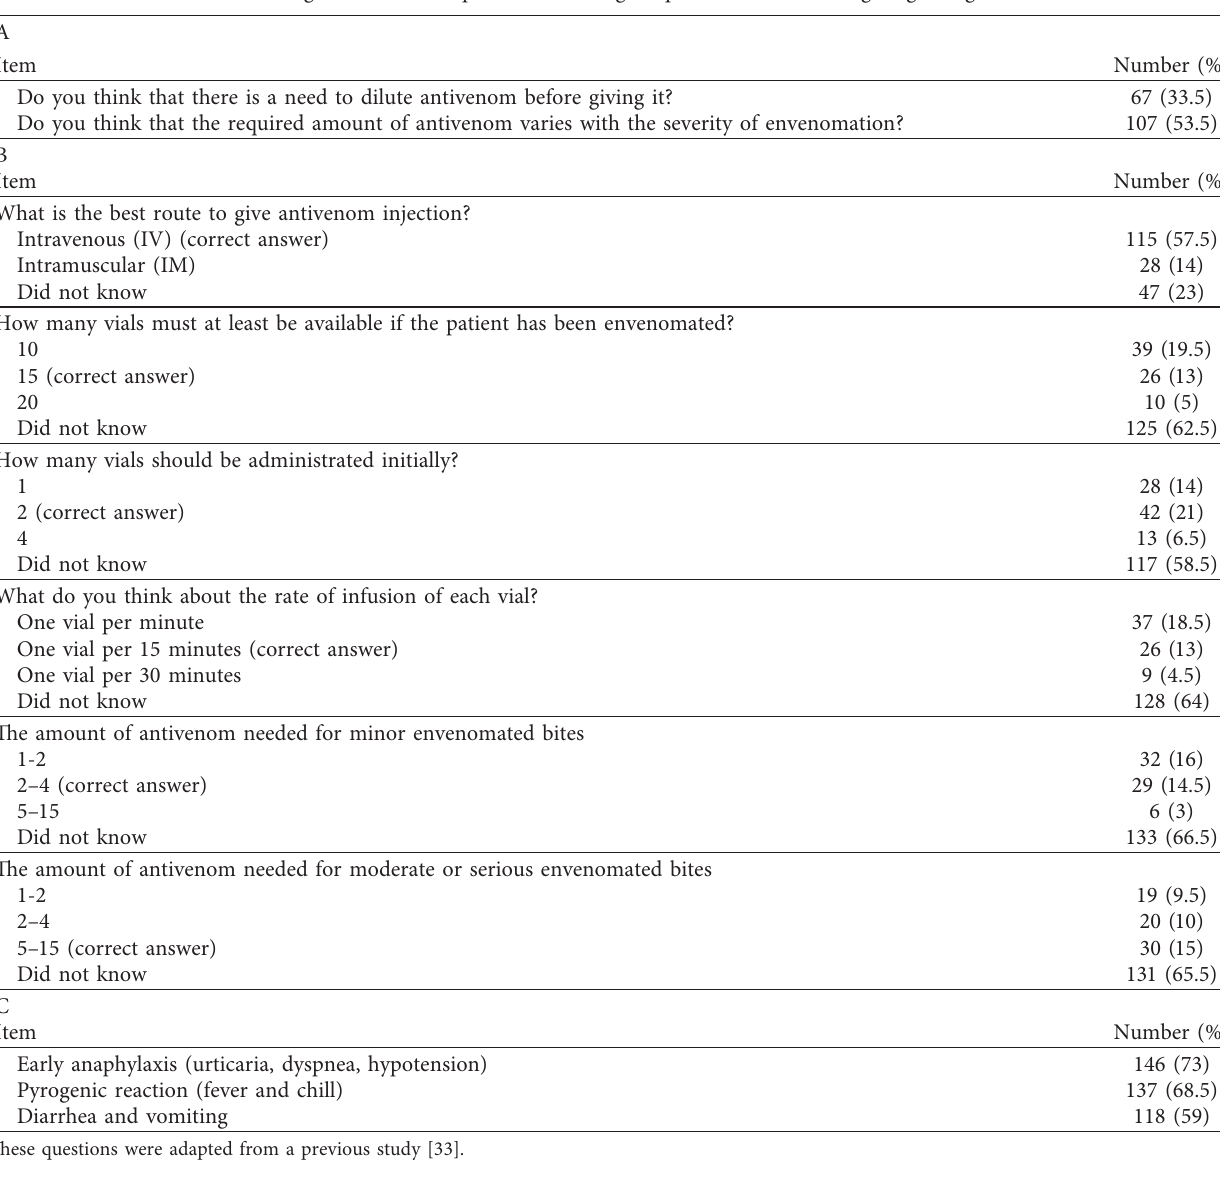
Table 6: Percentages of correct responses of nursing to questions on knowledge regarding